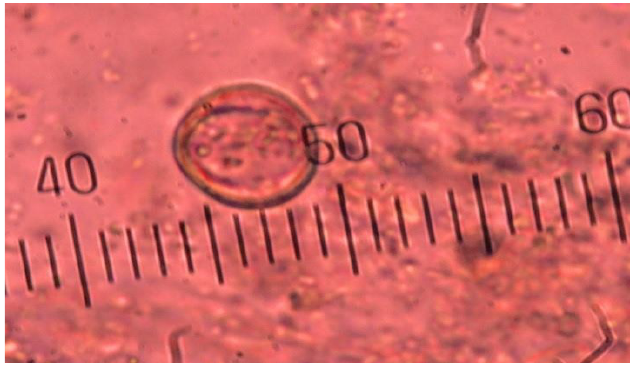
Eimeria intricata Non sporulated oocysts had spherical shape with average size 50x37.5±2 µm, with two layers of irregular granular form thick and striated wall had brown color, micropyle and distinct polar cap (Figure 3). Sporulated oocysts appeared as spherical shape with four sporocysts each one contained two sporozoites (Figure 4).